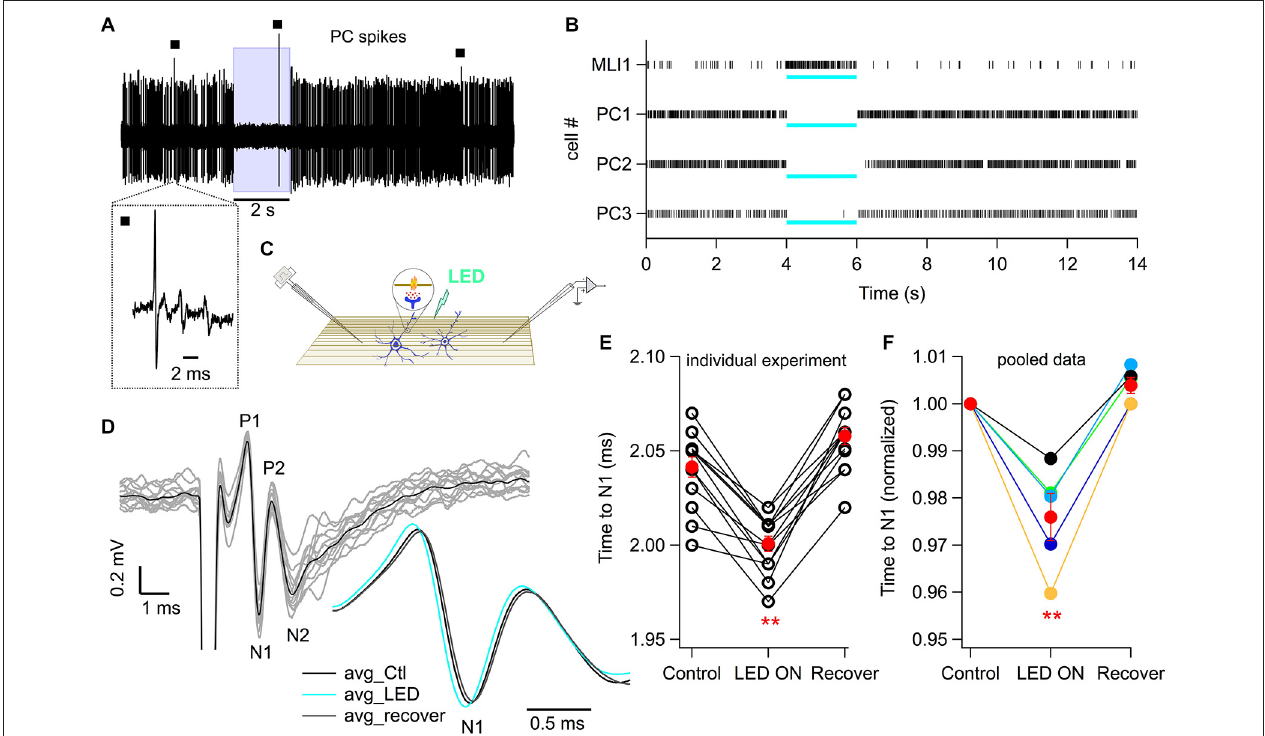
blue. The inset portrays the suggested MLI-to-PF GABAergic signaling. (D) PF volley traces recorded by an extracellular electrode placed superficially in the ML of an anesthetized ChR2-YFP mouse. PFs were stimulated at 1 Hz (100 µ s pulses, − 70 V) with a theta glass pipette (see “Materials and Methods” Section for details). The black trace is the average of 14 repetitions (single traces in gray). The inset shows an expanded view of the averaged N 1 wave, representing the AP propagating along the PFs, in control conditions (black), during light (blue; 1 s-long), and after recovery (gray). (E) The effect of photostimulation on the time to the N 1 wave for the experiment shown in (D) . Each data triplet represents a set of volley recordings in control conditions, followed by LED stimulation and recovery. Red dots: mean ± SEM across trials. p = 6 × 10 − 7 , paired Student’s t -test, n = 14 trials. (F) Effect of photostimulation on the time to N 1 wave for averaged values from five animals. Red dots: mean ± SEM across the five animals. p = 0.007, paired Student’s t -test. ** p <